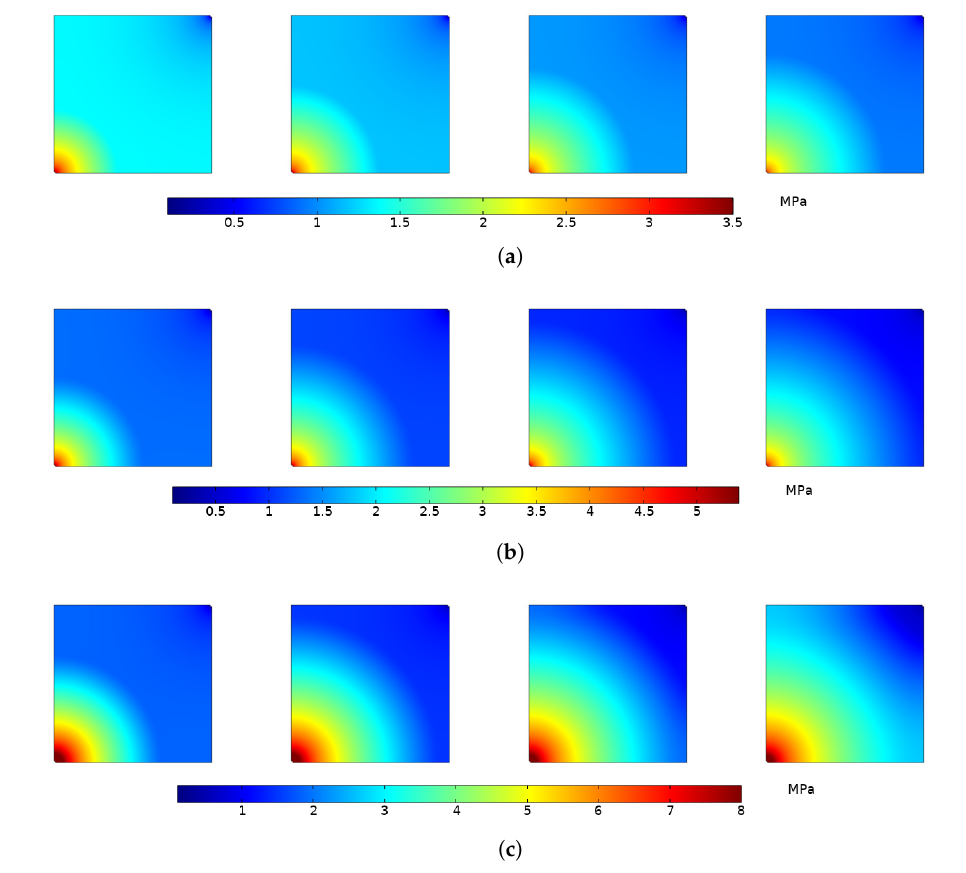
Figure 13. 300 days, 500 days, 1000 days, 1500 days Reservoir pressure cloud diagram ( a ) The injection pressure is 2 MPa ( b ) The injection pressure is 4 MPa ( c ) The injection pressure is 6